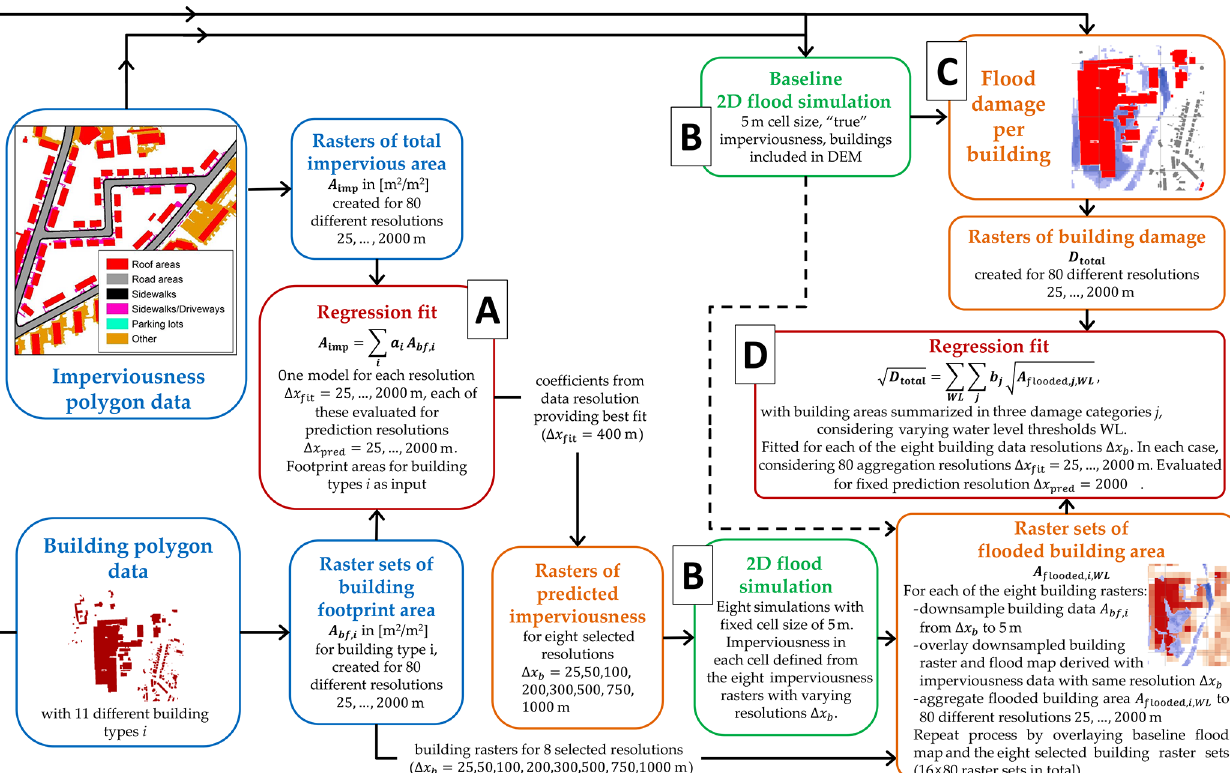
Figure 3. Outline of the analysis steps performed in this paper. Letters A to D refer to the parts of the “Methods” section where the corresponding step is detailed. The dashed line illustrates the case where flood maps from the baseline simulation were used to derive flooded building areas as input to damage regression. Note that the second baseline 2D flood simulation where buildings were not inserted in the DEM is not shown in the flow chart. Steps B and D were performed for a set of eight selected building raster resolutions (cid:49)x b to reduce the number of possible resolution combinations without compromising the overall